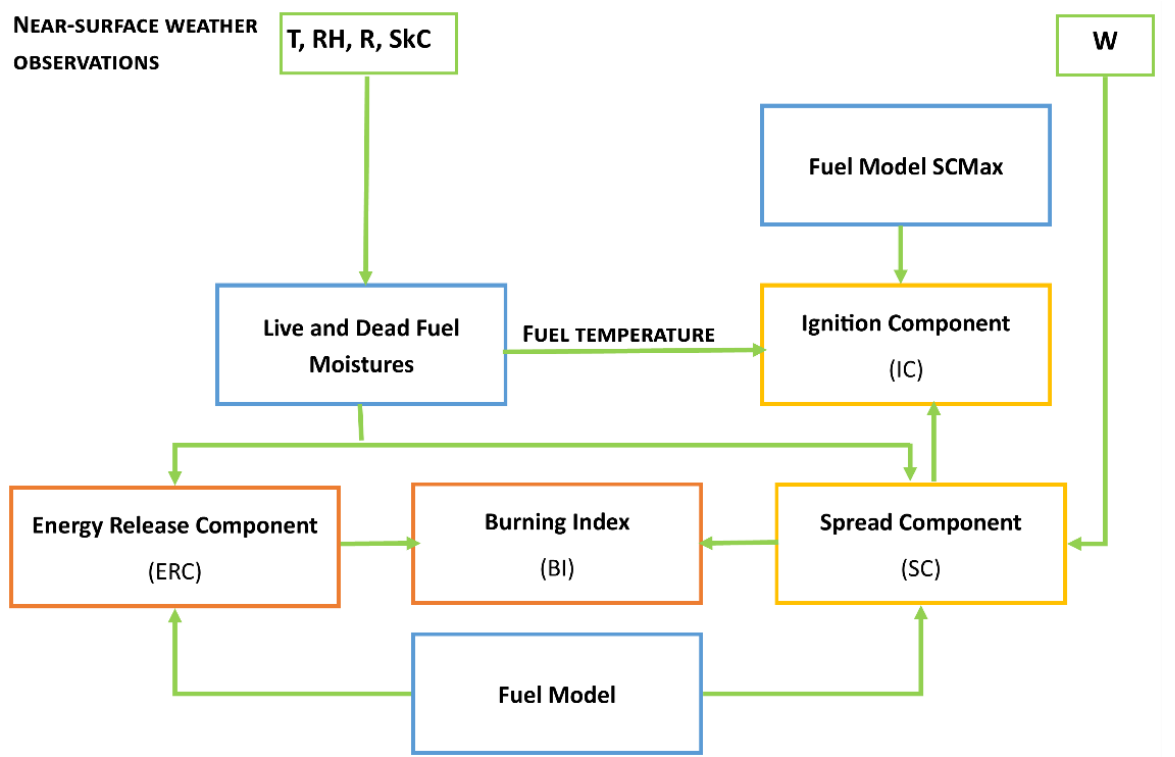
Figure A3. United States National Fire Danger Rating System schematics in which T (°C) is the air temperature, RH (%) is the relative humidity, W is the wind speed (km/h), R (mm) is the rain, and SkC (oktas) is the sky cover (Adapted from Luke and MacArthur [51]).